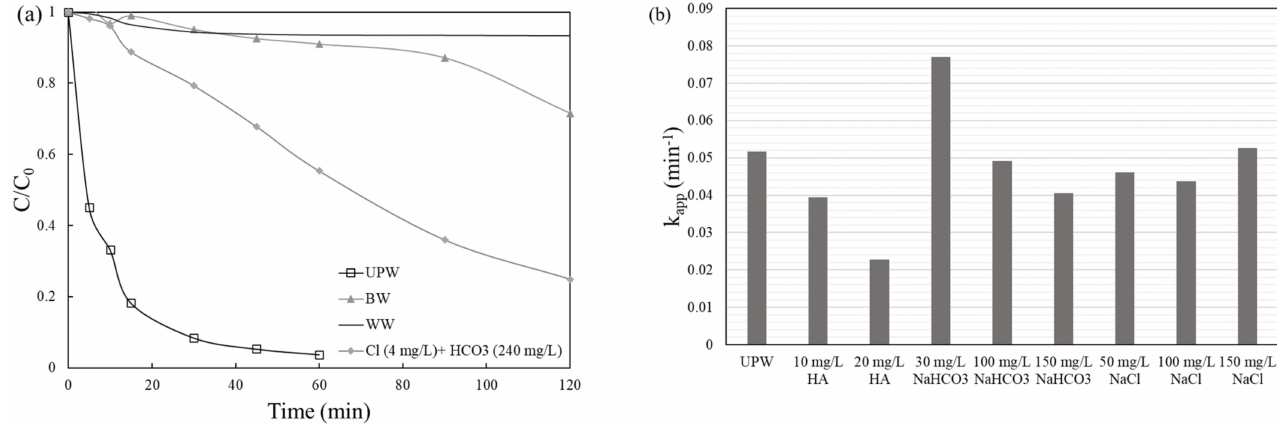
Figure 8. ( a ) Effect of water matrix on 0.5 mg/L VLS degradation with 1000 mg/L 0.25 MoS 2 /BiOCl under solar irradiation. ( b ) Constant apparent rates of the degradation of 0.5 mg/L VLS in UPW spiked with different